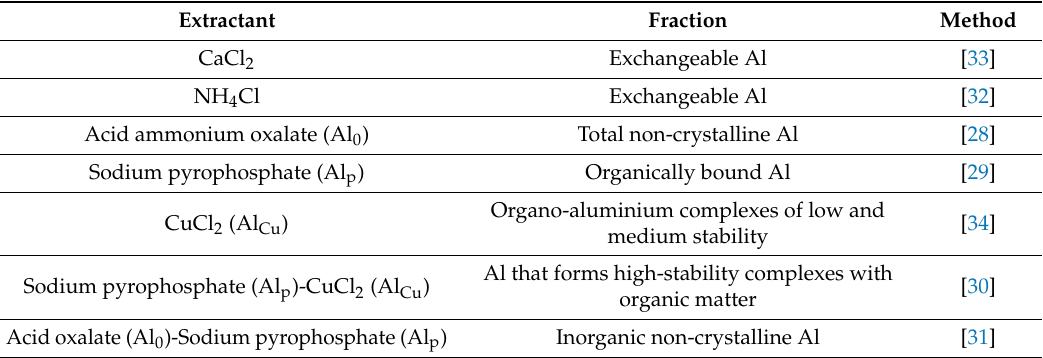
Table 1. Forms of aluminium (Al) extracted and